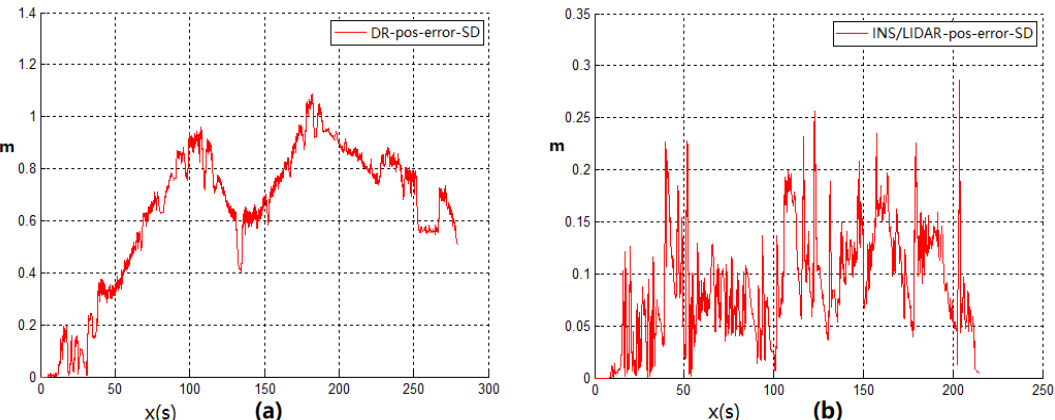
Figure 10. The comparison standard deviation error graph of the integrated navigation algorithm in the second experiment (the second part of the experiment 2). ( a ) The DR algorithm trajectory error ( b ) The INS/LIDAR algorithm trajectory error.